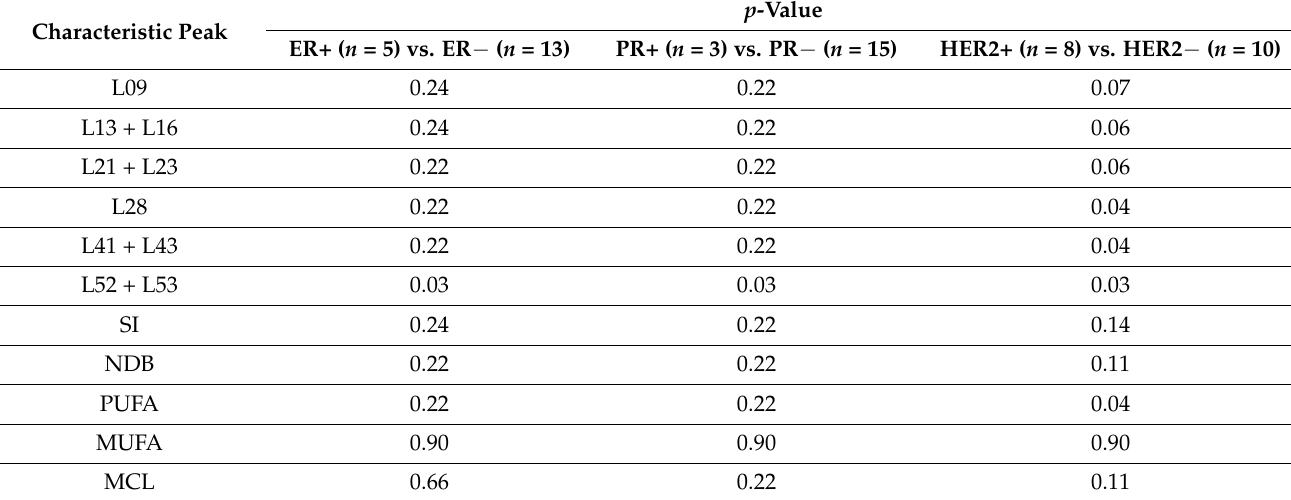
Table 2. Fat peak p -values obtained for differentiating tumors grouped with respect to ER, PR, and HER2 status.